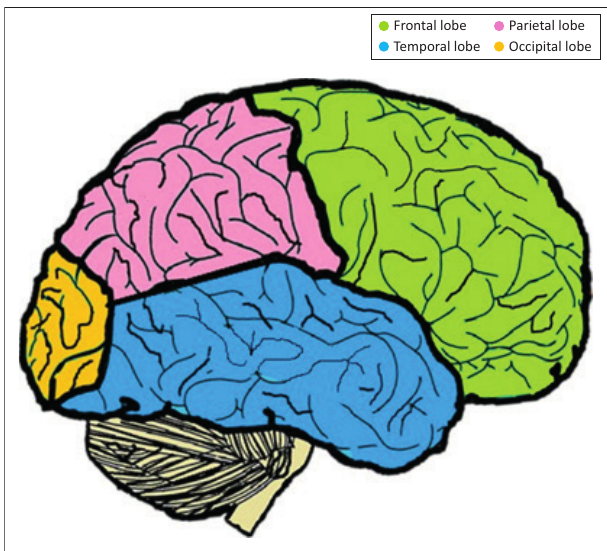
FIGURE 4: Illustration of the cortical lobes.